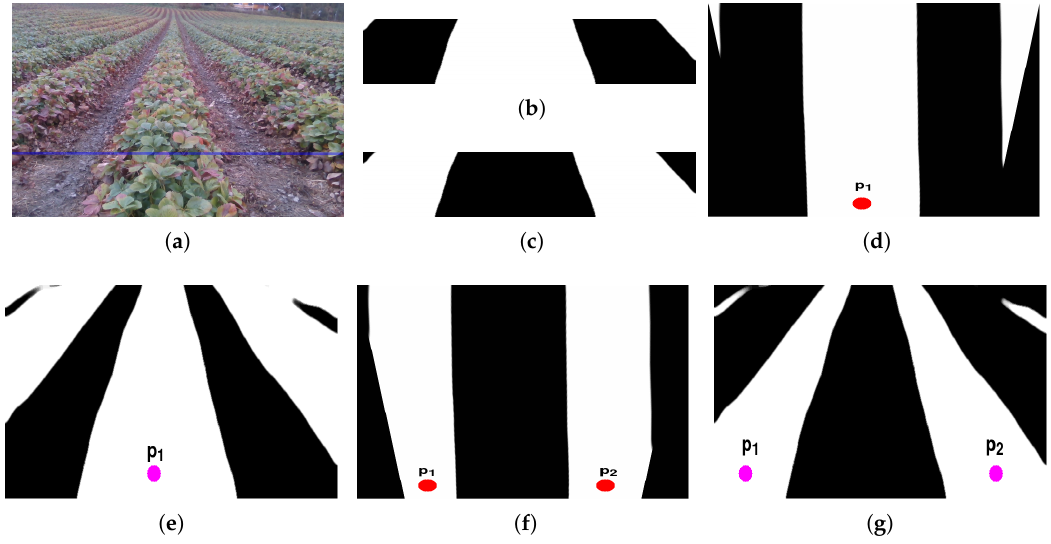
Figure 4. The peaks are estimated (red) on both the crop and lane label by summing the columns of the warped image. The peaks are projected (pink) back by inverse warping on the segmented image. ( a ) Incoming RGB image, ( b ) Crop Label, ( c ) Lane Label, ( d ) Estimated Peaks (Warped Lane Label), ( e ) Projected Peaks (Inverse Warped Lane Label), ( f ) Estimated Peaks (Warped Crop Label), ( g ) Projected Peaks (Inverse Warped Crop